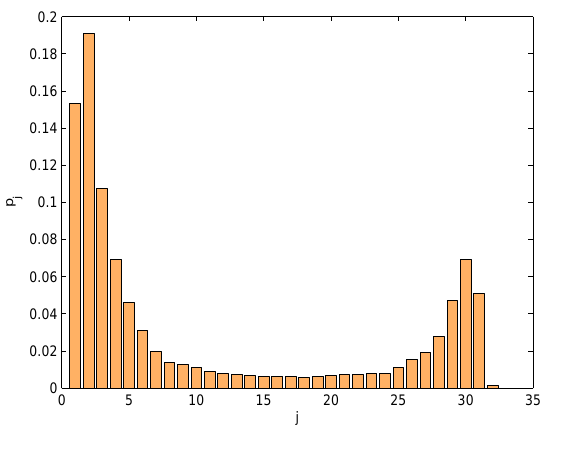
Figure 6. SYNAPSE’s encoding dis- tribution p ( j ) , returning the probability that j original packets out of a source page of K = 32 packets are combined to generate an encoding packet. Repro- duced with permission from IEEE [44].